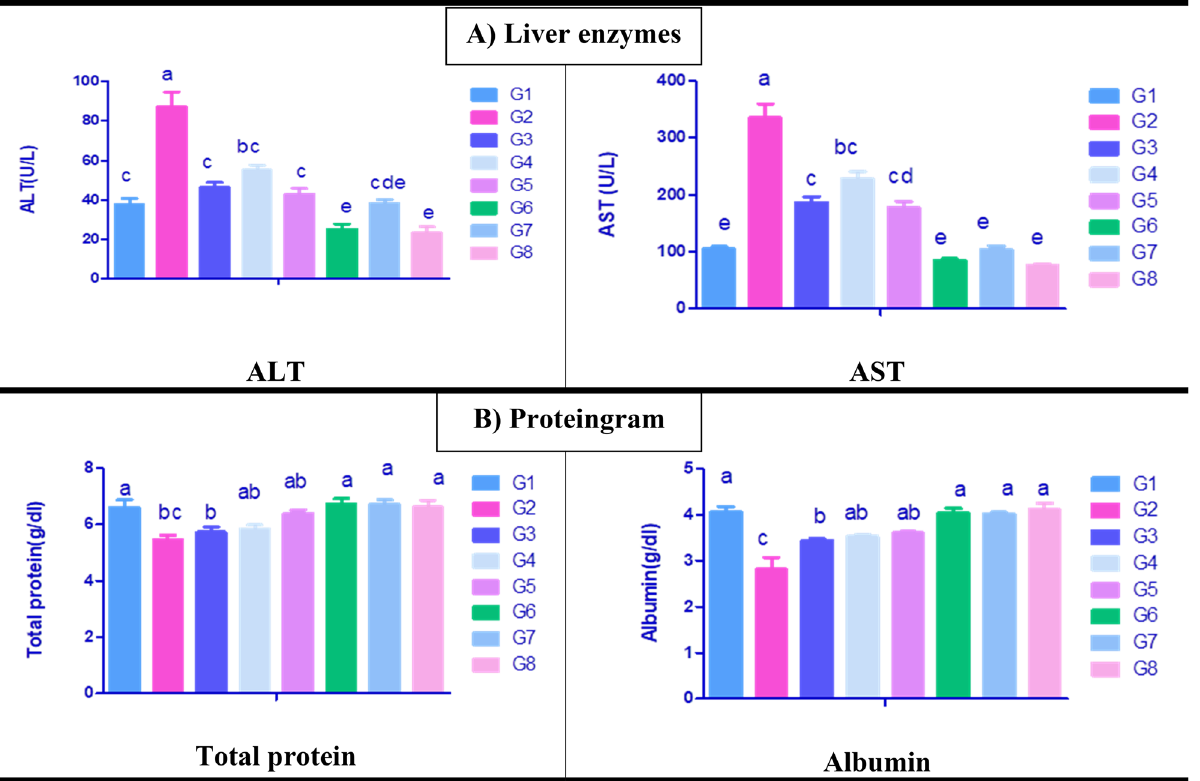
Figure 1. Serum biochemical parameters of liver enzymes and proteinogram of control and different treated rat groups. G1 = Control group, G2 = Paracetamol, G3 = Silymarin + Paracetamol, G4 = Chlorella vulgaris + Paracetamol, G5 = Chlorella vulgaris + Thiamine + Paracetamol, G6 = Silymarin, G7 = Chlorella vulgaris, G8 = Chlorella vulgaris + Thiamine. ALT = Alanine amino transferase, AST = Aspartate amino transferase. Data are presented as means ± SEM (n = 6). Different letter means significant difference effects in the same time